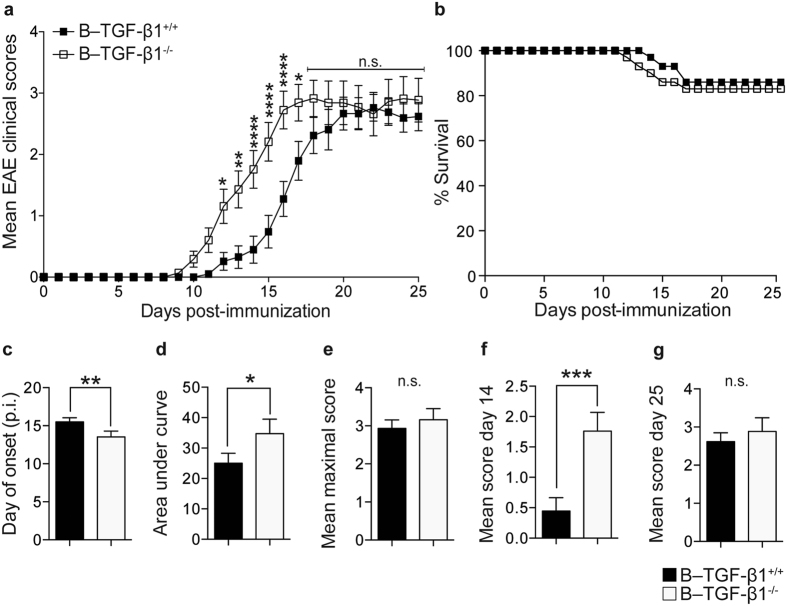
B cell-derived TGF-β1 delays the induction phase of EAE induced by mouse MOG protein.(a) B–TGF-β1+/+ (black) and B–TGF-β1−/− (open) mice were immunized with recombinant mouse MOG (rmMOG) protein and monitored daily for neurologic signs. Results are presented as mean ± SEM for each day post-immunization. Two-way ANOVA was used to compare the daily EAE scores (*P < 0.05; **P < 0.01; ***P < 0.001; and ****P < 0.0001). (b) Percentage survival of mice during EAE course. (c) Day of EAE onset, (d) area under the curve (AUC), (e) mean maximal clinical score, (f) mean maximal score during acute phase (day 14), (g) mean maximal score during chronic phase (day 25). Data are mean ± SEM (*P < 0.05; **P < 0.01; and ***P < 0.001 by Mann-Whitney U-test. Results are a composite of 3 independent experiments of n = 9–10 mice/group with similar results.